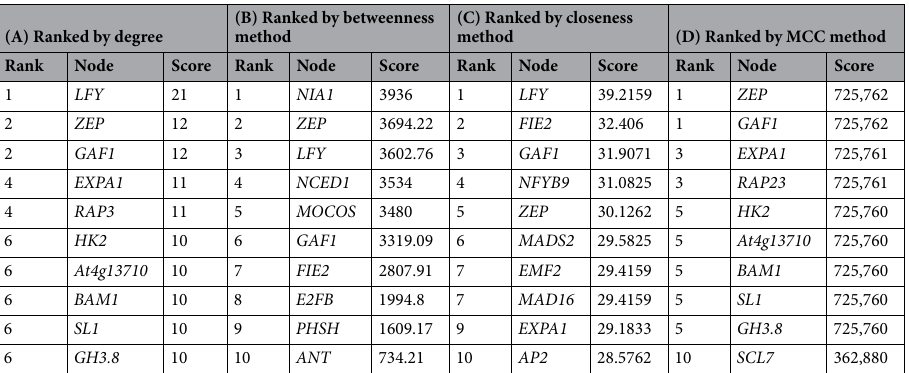
Table 1. Topological analysis—degree, betweenness, closeness centrality and cluster analysis of the network analyzed using Cytohubba